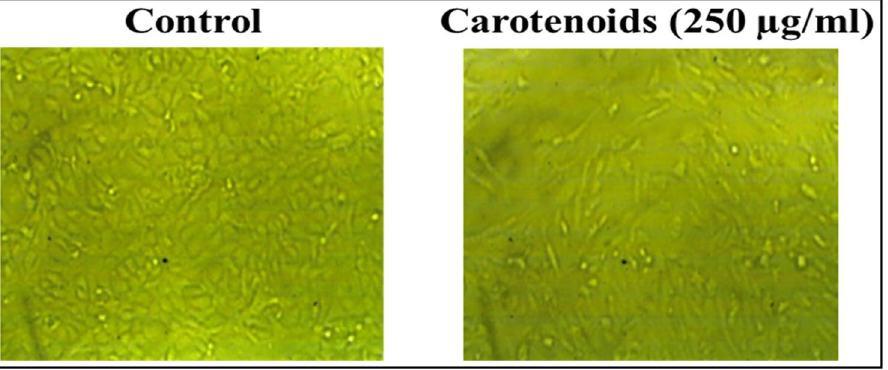
Figure 11. Effect of Kocuria sp. RAM1 carotenoids on HSV-1 infectivity. The data represent the mean ± SD (n = 3).